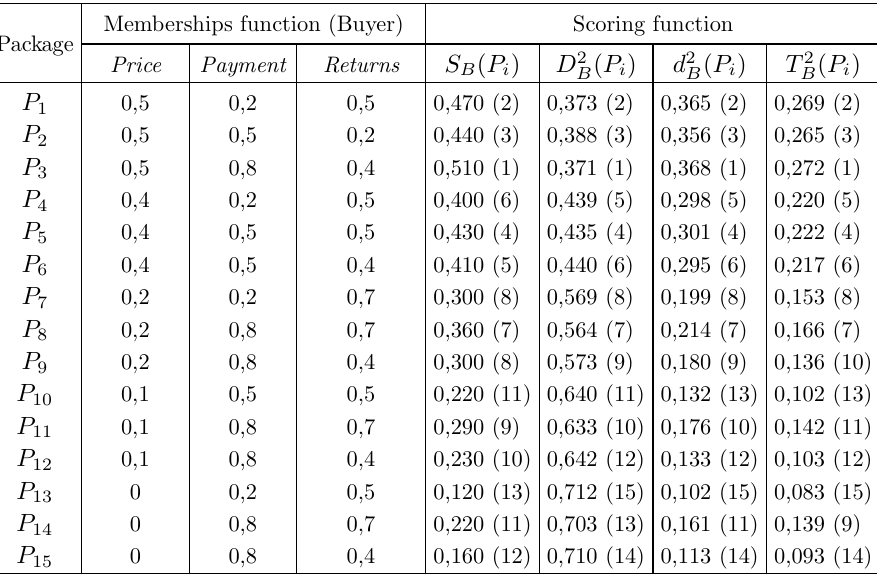
Buyer’s scoring systems